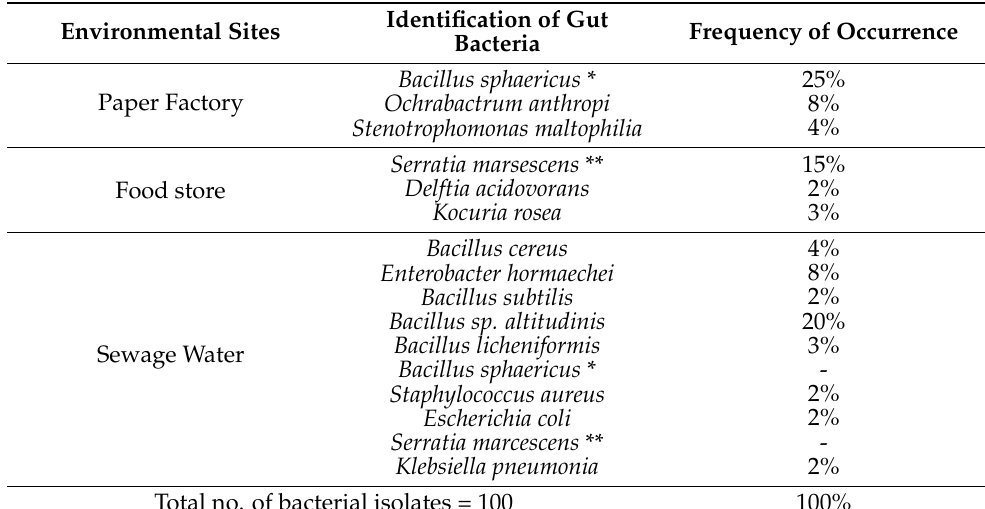
Table 1. Summarizing list of isolated gut bacteria of Periplaneta americana L. from the three collecting sites and their frequency.